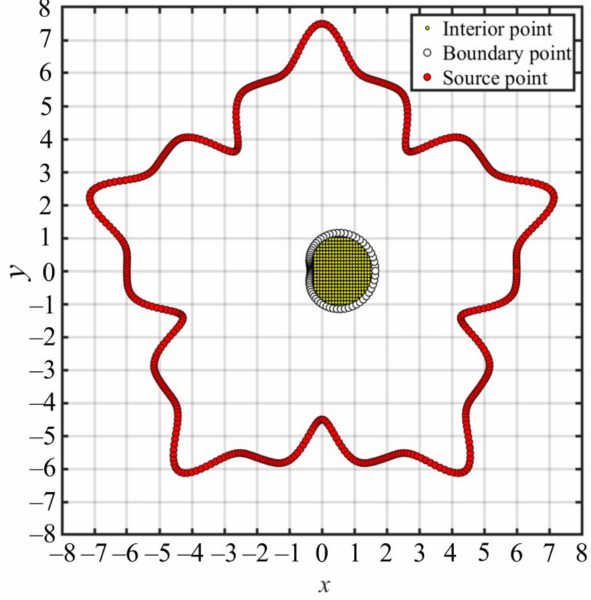
Figure 6. The fictitious